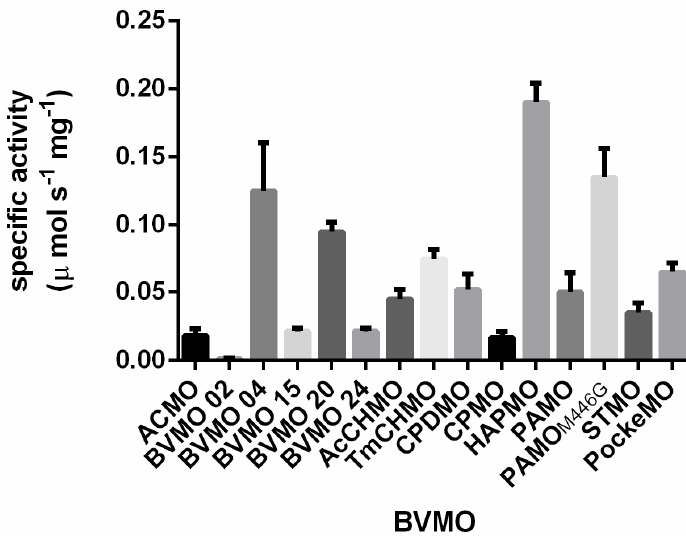
Figure 2. Specific activities of BVMOs on furfural.